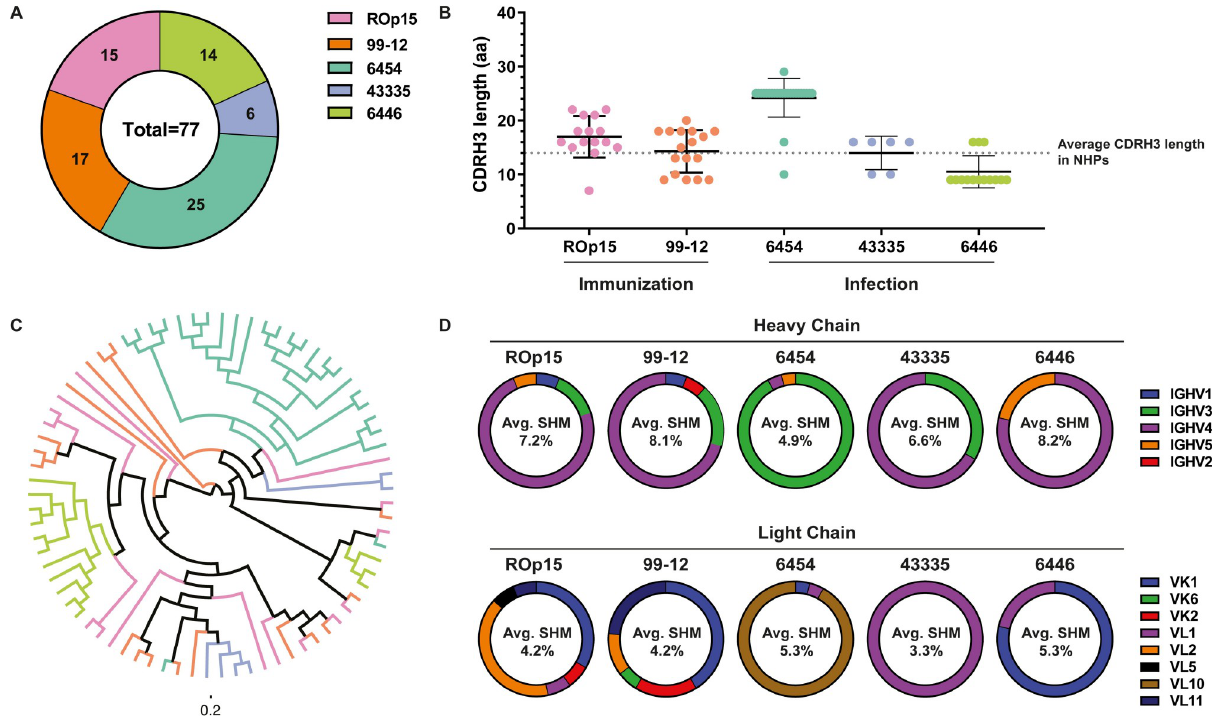
Fig 1. Isolated mAbs induced by BG505 SOSIP are more clonally divergent than those induced by BG505 SHIV. (A) In total, we successfully expressed 32 and 45 mAbs from two BG505 SOSIP (ROp15 and 99–12) and three BG505 SHIV-infected (6453, 43335, and 6446) NHPs, respectively. (B) CDRH3 amino acid length of individual mAbs isolated from the BG505 SOSIP-immunized and BG505 SHIV-infected NHPs. (C) Phylogenetic analysis using the heavy chain VDJ sequences to assess the evolutionary relationship between the mAbs and to compare the sequence variability between the different NHPs. Similar colors are used as panel A and B to distinguish the mAbs per NHP. (D) Variable gene usage for the heavy and light chains of the isolated mAbs. Average amount of somatic hypermutation (SHM) is indicated for each of the NHPs. SHM is determined as the percentage of nucleotide differences with a germline VH, VL, or VK gene